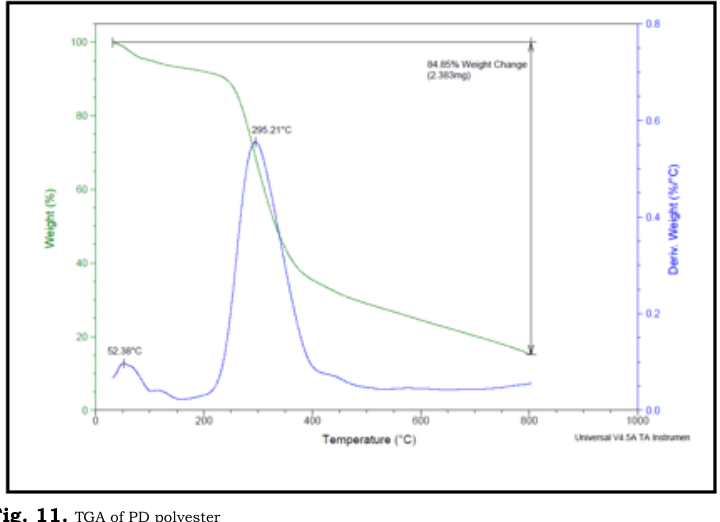
Fig. 11. TGA of PD polyester